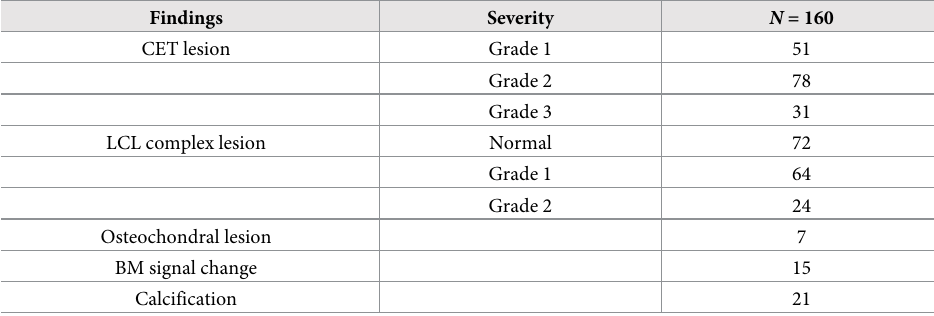
Table 2. Distribution of radiologic